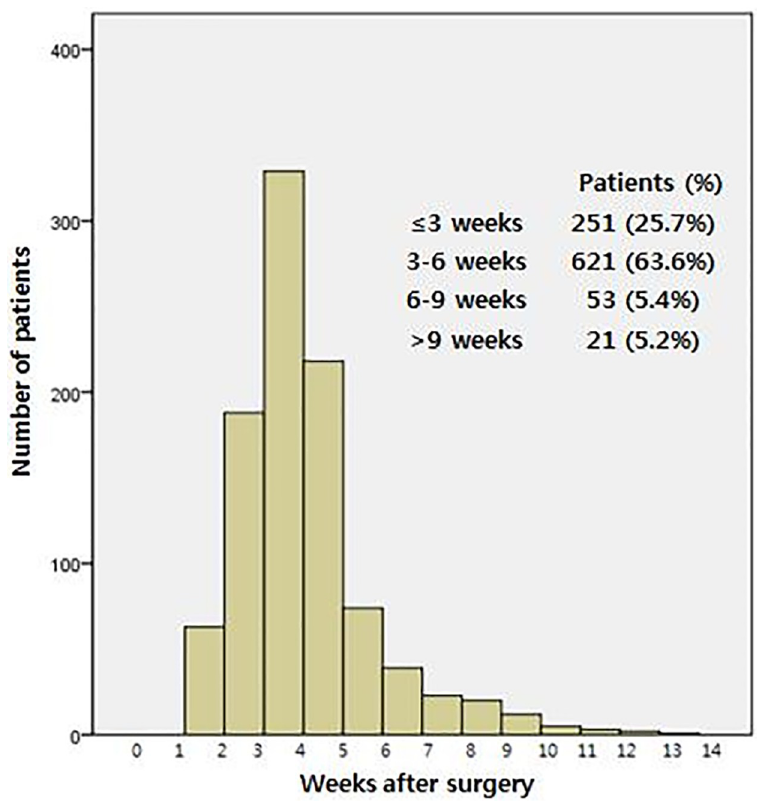
Fig 1. Distribution of the time to adjuvant chemotherapy in 977